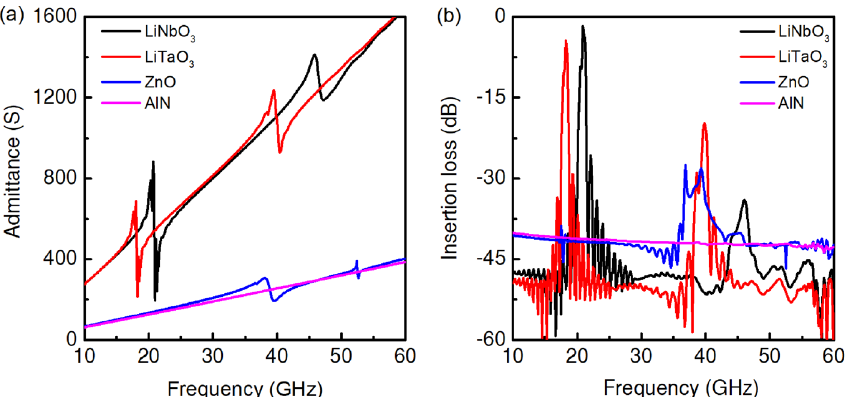
Figure 3. Frequency characteristics of piezoelectric material/h-BN/SiO 2 SAW filters. ( a ) Electrical input admittance and ( b ) Insertion loss ( S 21 ) of the multilayer structures. 30 nm LiNbO 3 , LiTaO 3 , ZnO, and AlN are placed on h-BN/SiO 2 ( h h-BN = 4 nm).